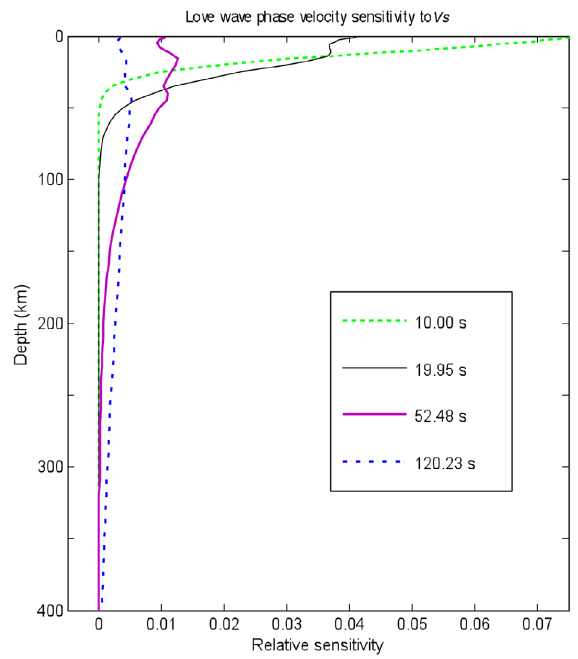
Figure 7. Relative sensitivity of phase velocity ( c ) of Love waves to S -wave velocity ( Vs ) versus depth of the accepted model (Table 5) at various representative periods. The sensitivity shows partial deriv- atives ∂ c / ∂ Vs in a layer of 1 km centered at the given